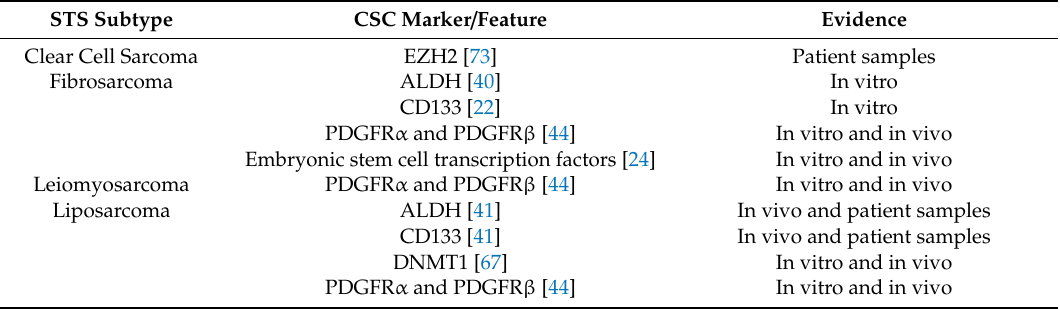
Table 1. Overview of Cancer stem cell (CSC)-associated markers and features in some soft-tissue sarcoma (STS)